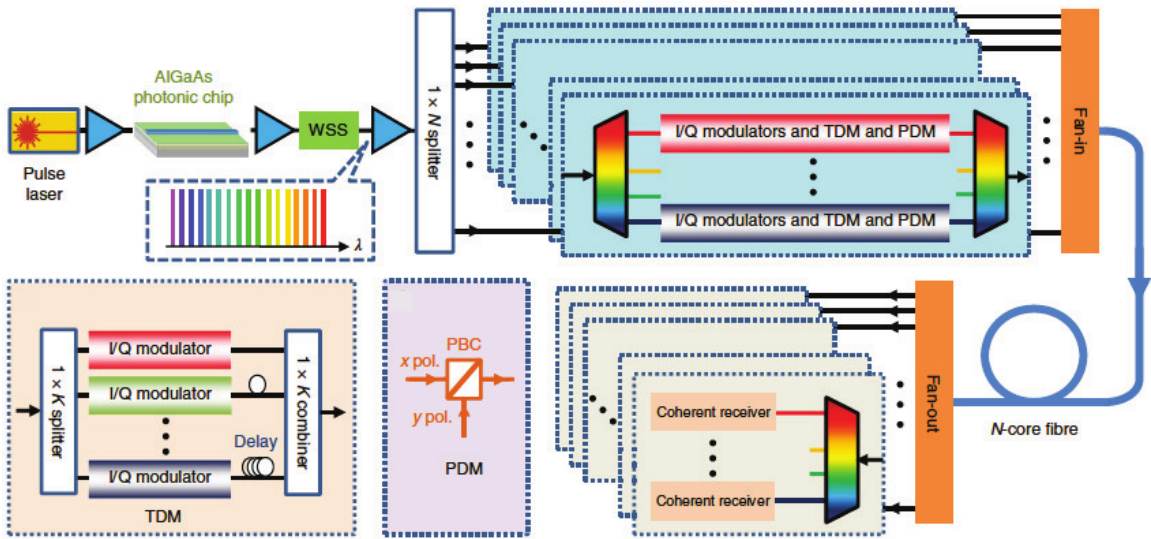
Figure 16. Generation and transmission of multi-100 Tbit/s data carried by an AlGaAs-OI SPM-based frequency comb. Reprinted by permission from Nature [156],